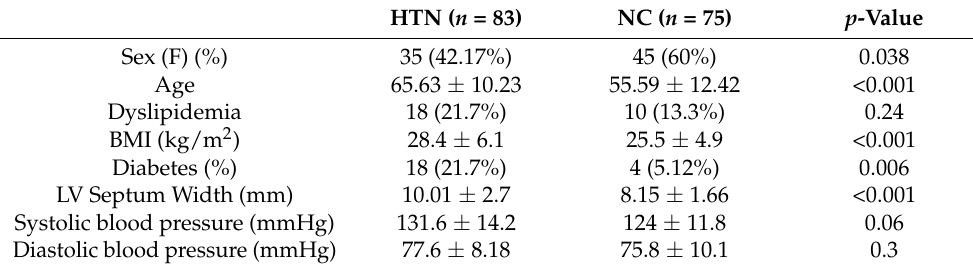
Table 1. Baseline clinical features of selected patients. HTN: hypertension; NC: controls.